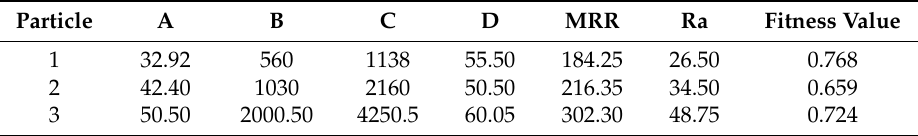
Table 8. New position of particles after the first iteration.